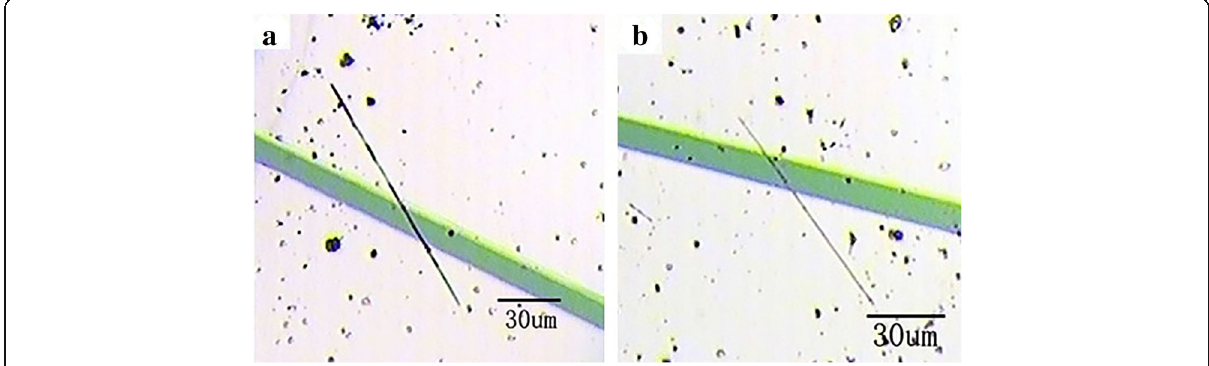
Fig. 1 Optical microscope photos of a Eu-SnO 2 NB and b SnO 2 NB